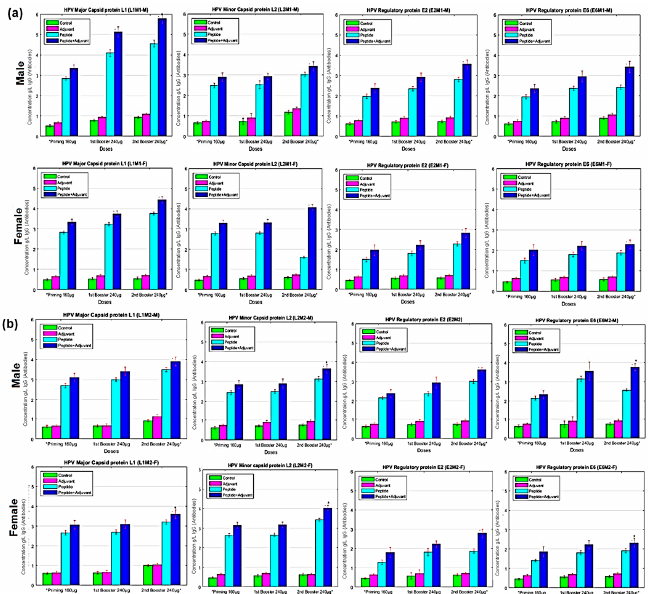
Figure 4. IgG analysis of ( a ) MHC Class-I ( b ) MHC Class-II, antigenic peptides measured by ELISA assays. Blood samples of experimental male and female rats immunized with potential epitopes (individual peptides) emulsified with and without adjuvant at primary, first and second booster doses. The titer rate of IgG antibodies is given in g/L. All data were compared to control group. Bars represent ‘mean; which is signified (*) with p -value (<0.01) and standard deviation